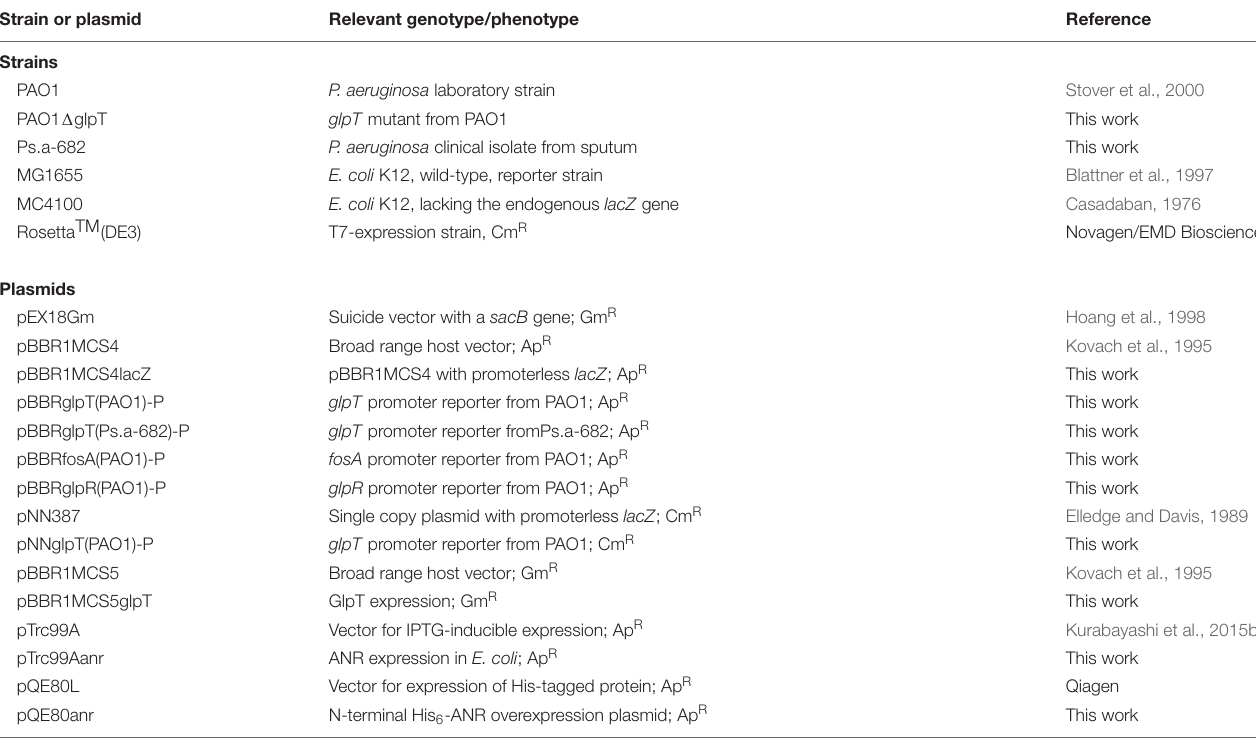
TABLE 1 | Strains and plasmids used in this study.